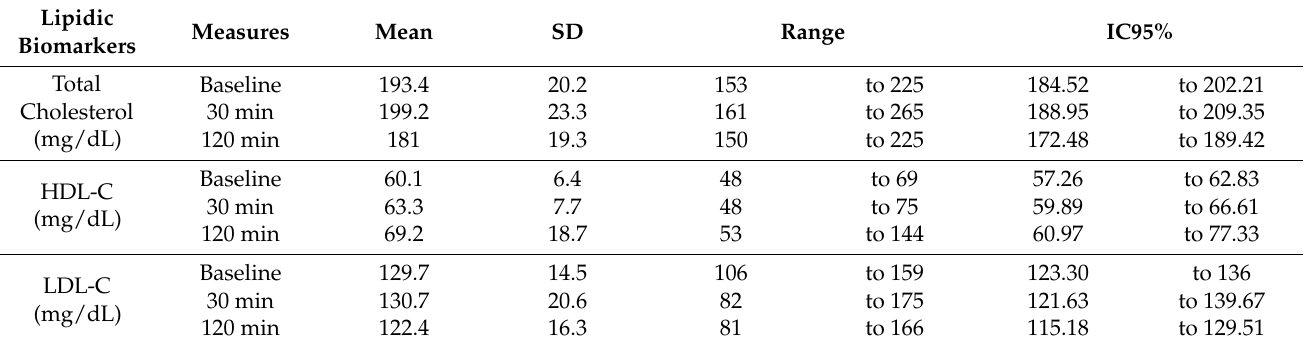
Table 3. Descriptive statistics on the concentration of lipoproteins in in the three measurements of the study in human serum of cannabis